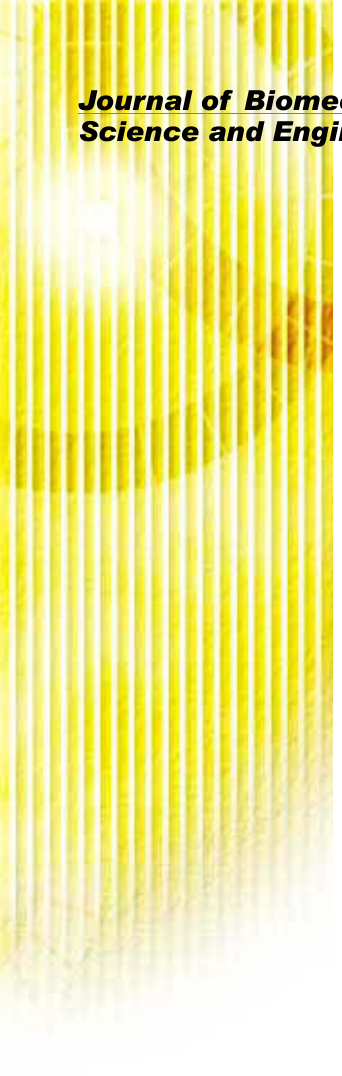
Fig.3: Top panels show examples of the velocity (left) and pressure (right) waveforms, in site1 (blue), site2 (green) and site3 (red): Noise=0%. Bottom panels show the Fourier harmonics of these